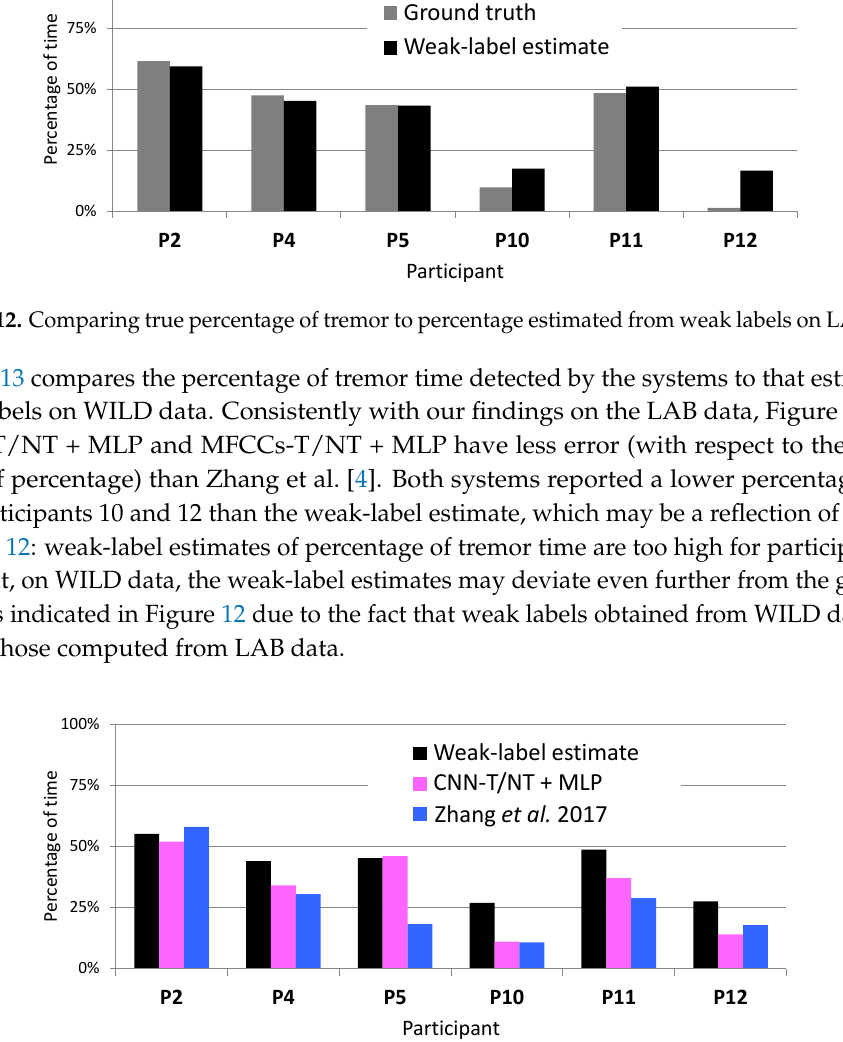
Figure 13. Weak-label estimate of percentage of tremor compared to percentages output by the automatic systems on WILD